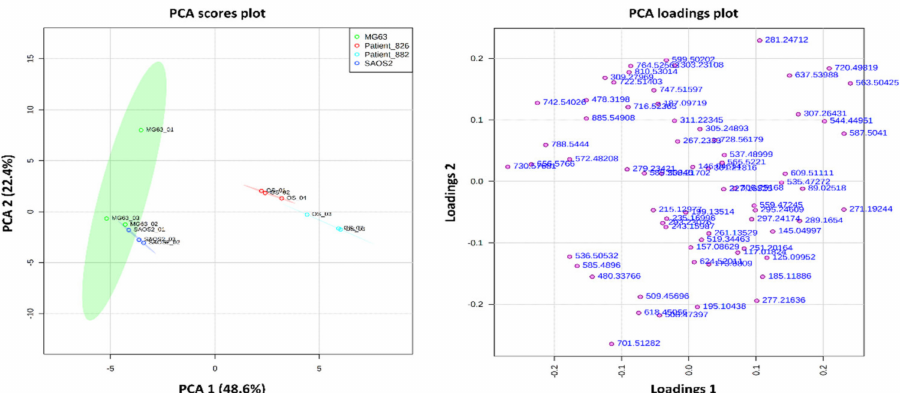
Figure 7. PCA scores and loadings plot show separation of the OS aggregoid models from the OS human tissue samples. Principle components, PC 1 (48.6%) and PC 2 (22.4%) showed the best separation between sample groups. The discriminatory m / z values of interest were distributed separately from the cluster of peaks. Samples were grouped with 95% confidence, MG63 (green), and SAOS-2 (blue), OS patient_826 (red) and OS patient_882 (light